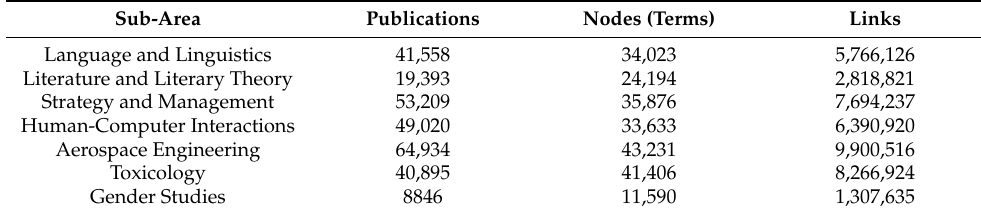
Table 3. Network sizes of the term co-occurrence networks in the selected Scopus sub